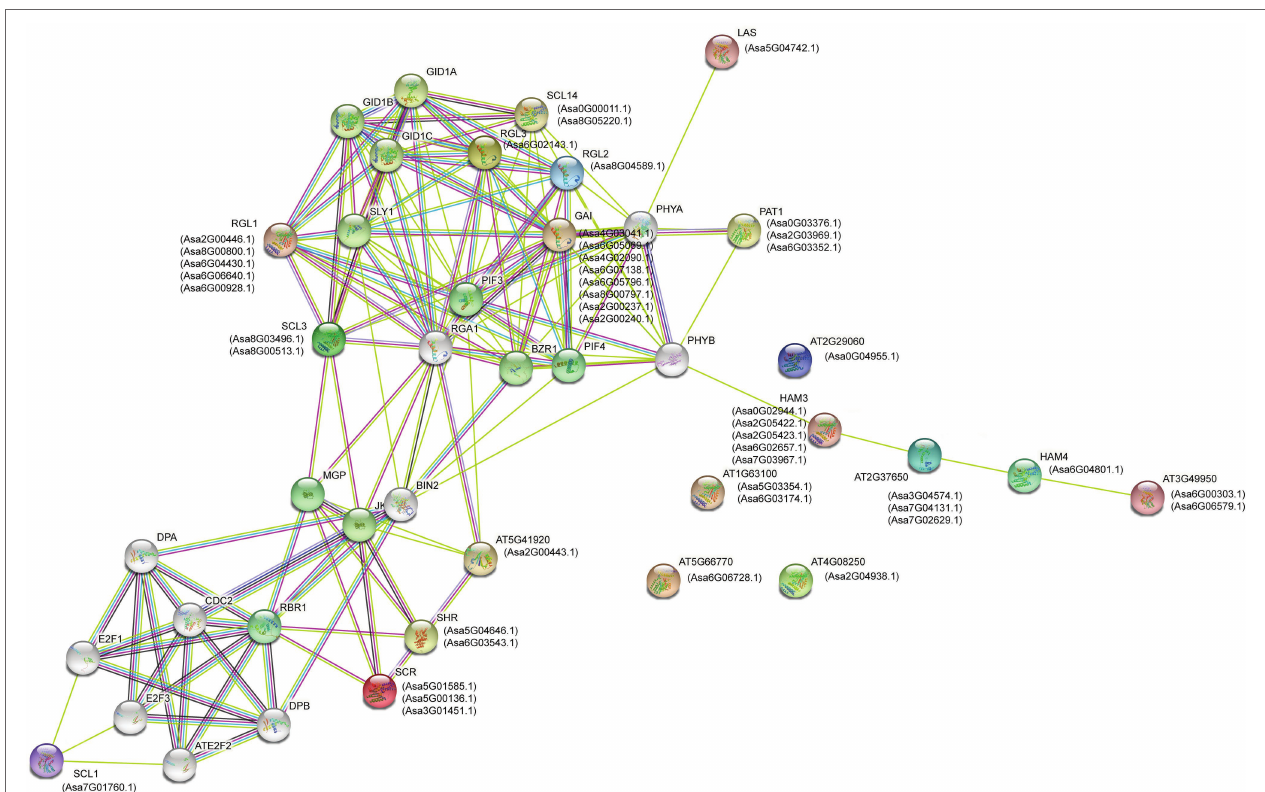
FIGURE 5 | Protein–protein interaction network of the GRAS proteins in garlic with the orthologous ones in Arabidopsis